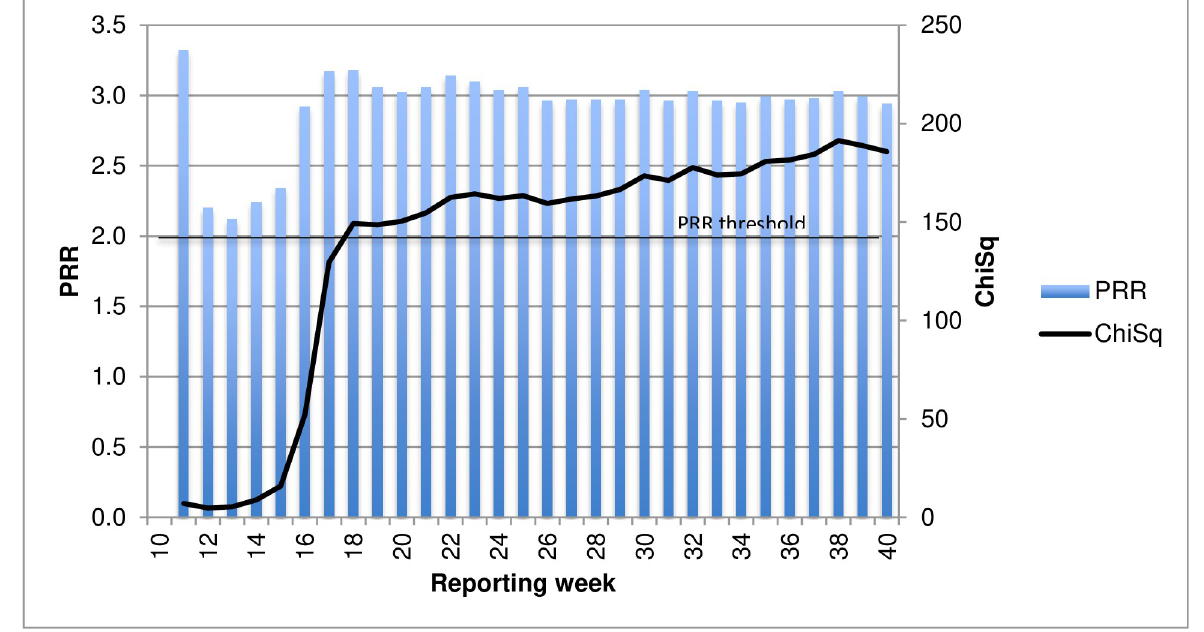
Fig 5. PRR cumulative and ChiSq for influenza vaccines and fever reactions by reporting week, 2010.